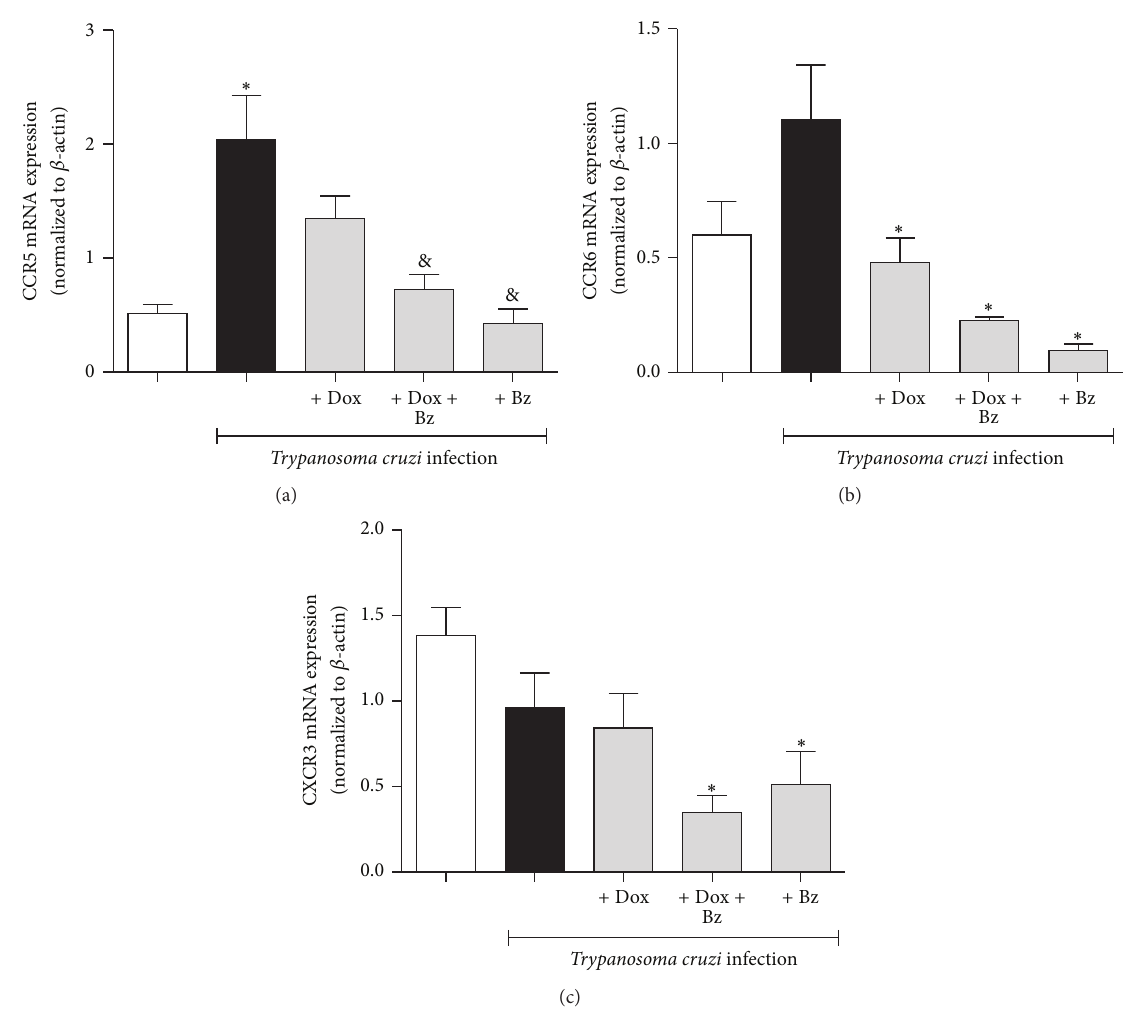
Figure 4: Expression of Th1-like chemokine receptors in the cardiac tissue Trypanosoma cruzi -infected dogs. Th1-like chemokine receptors (CCR5, CCR6, and CXCR3) mRNA expression evaluated in the left ventricle tissues. Data are representative of the groups ( 𝑛 = 5 animals) in which the expression of chemokine receptors was normalized to the constitutive beta-actin. ∗ means difference ( 𝑝 < 0.05 ) in relation to the noninfected group; & means difference ( 𝑝 < 0.05 ) in relation to the infected group without